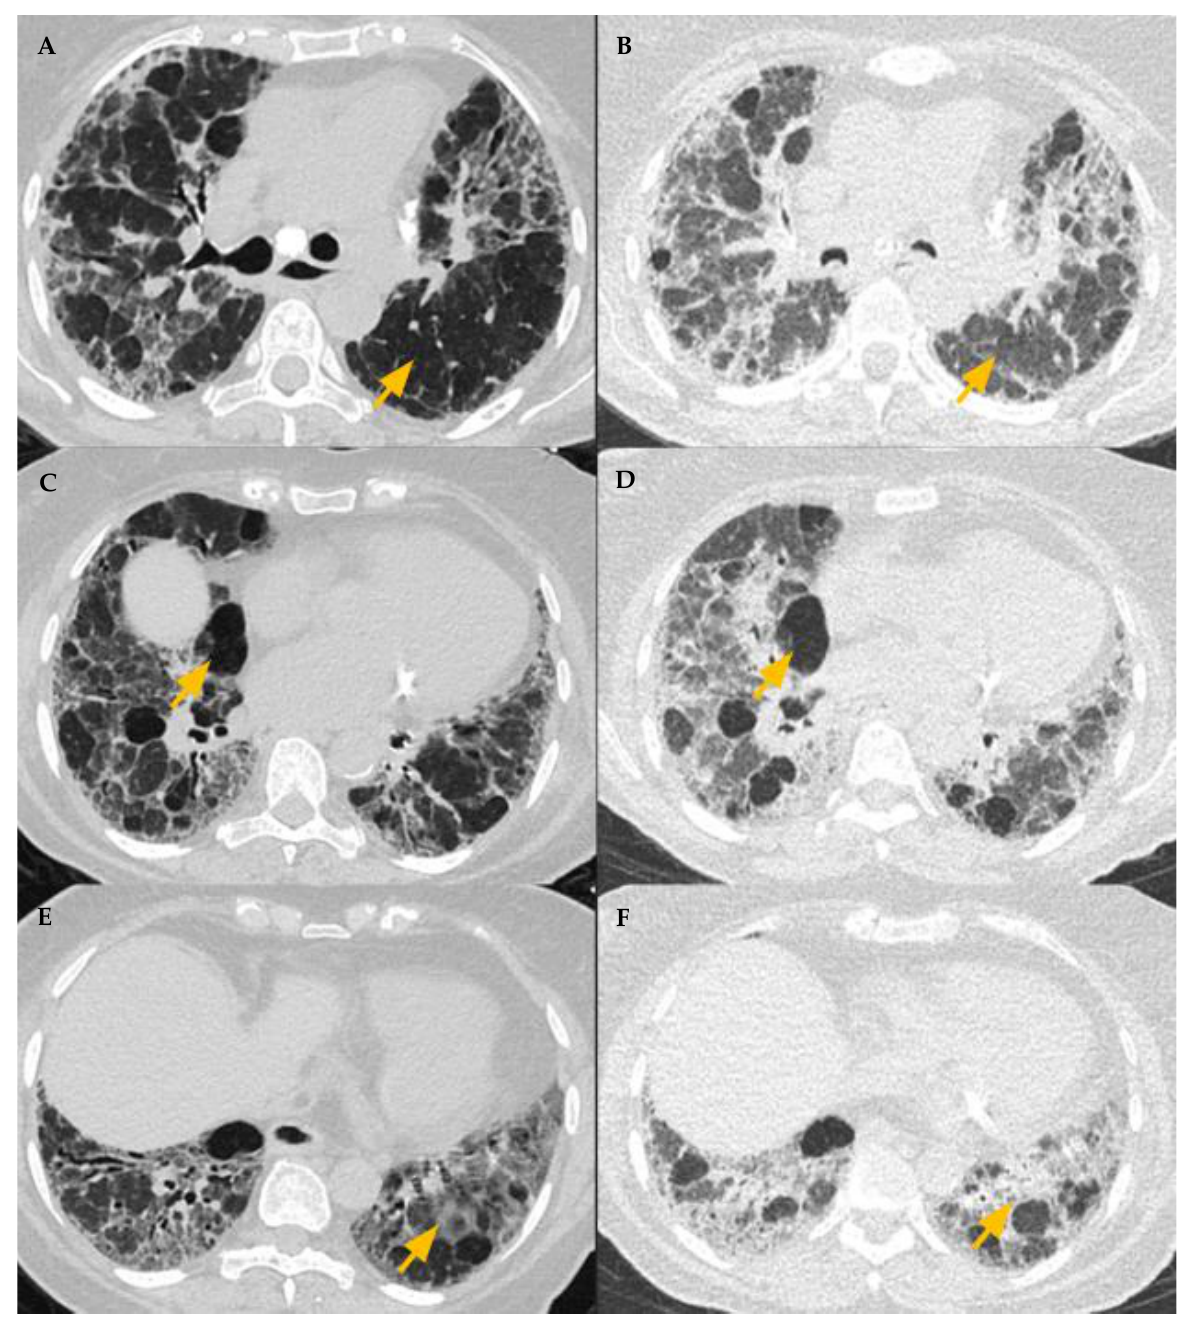
Figure 7. Three density pattern depicts simultaneous obstructive and infiltrative processes mani- festing as air trapping (low density) and ground glass attenuation (high density), respectively, with areas of intervening normal lung parenchyma of intermediate density. Normal lung parenchyma ( A ) shows expected increased attenuation on expiration ( B ). Obstructive airway disease (air trap- ping) with decreased attenuation and vascularity on inspiration and expiration ( C , D ). GGO ( E ) with further increased attenuation on expiration ( F ).